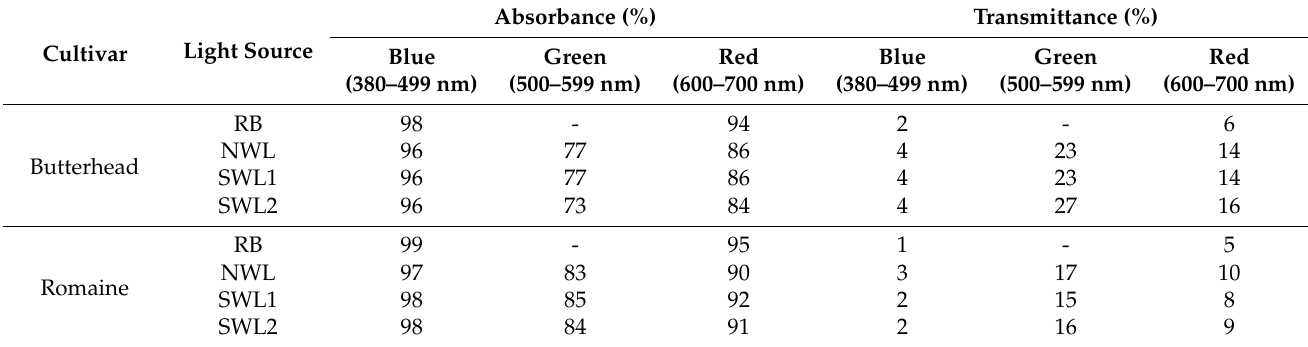
Table 4. Absorbance and transmittance rates of butterhead and romaine lettuce at each light source with the same PPFD.